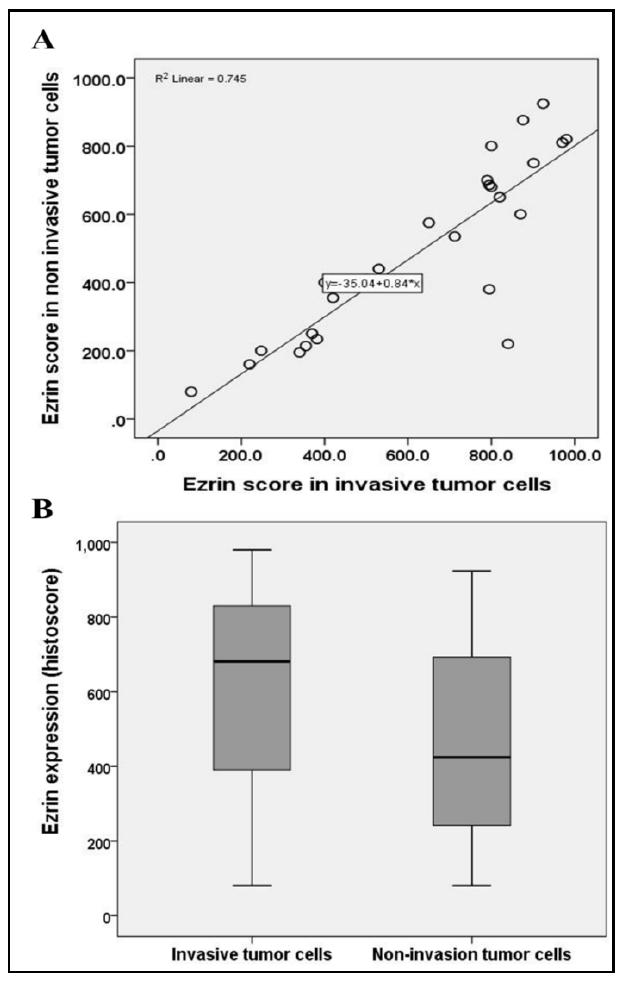
Figure 3: Expression of ezrin in invasive and